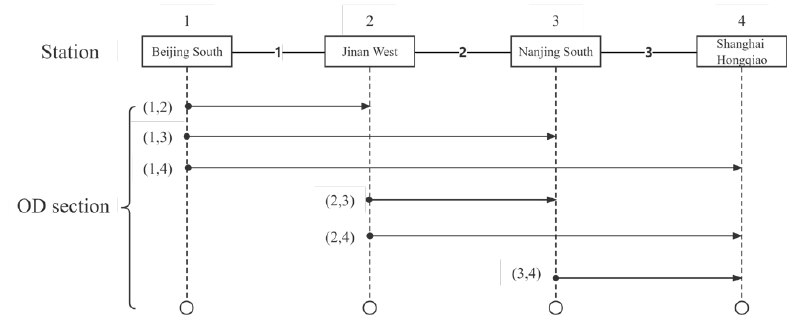
Figure 3. Diagram of the seats occupied by number of tickets.